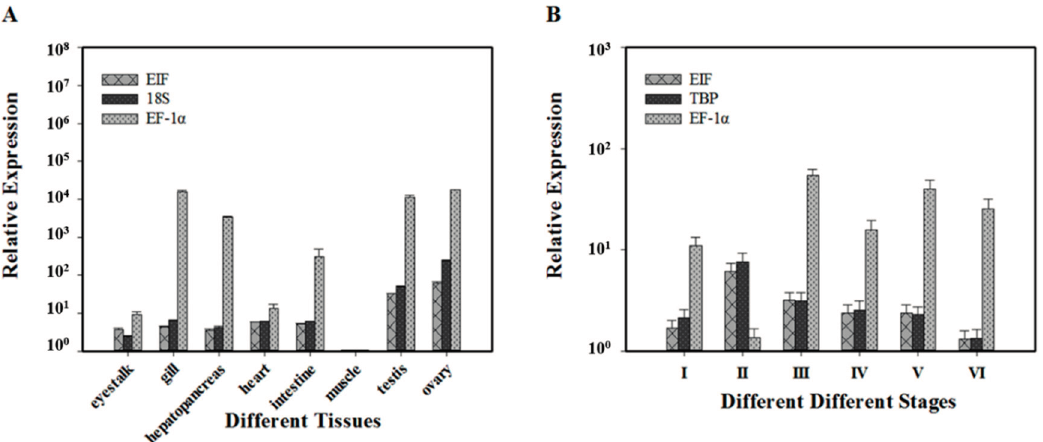
Figure 5. Expression levels of Vg using different candidate reference genes for normalization. ( A ) Vg expression patterns in eight different tissues. Different bars indicate Vg expression levels normalized against EIF , 18S and EF-1 α ; ( B ) Vg expression patterns in six different ovarian developmental stages. Different bars indicate Vg expression levels normalized against EIF , TBP and EF-1 α . No developmental stage = I, early developmental stage = II, previtellogenic stage = III, vitellogenic stage = IV, mature stage = V, post-spawning stage = VI.